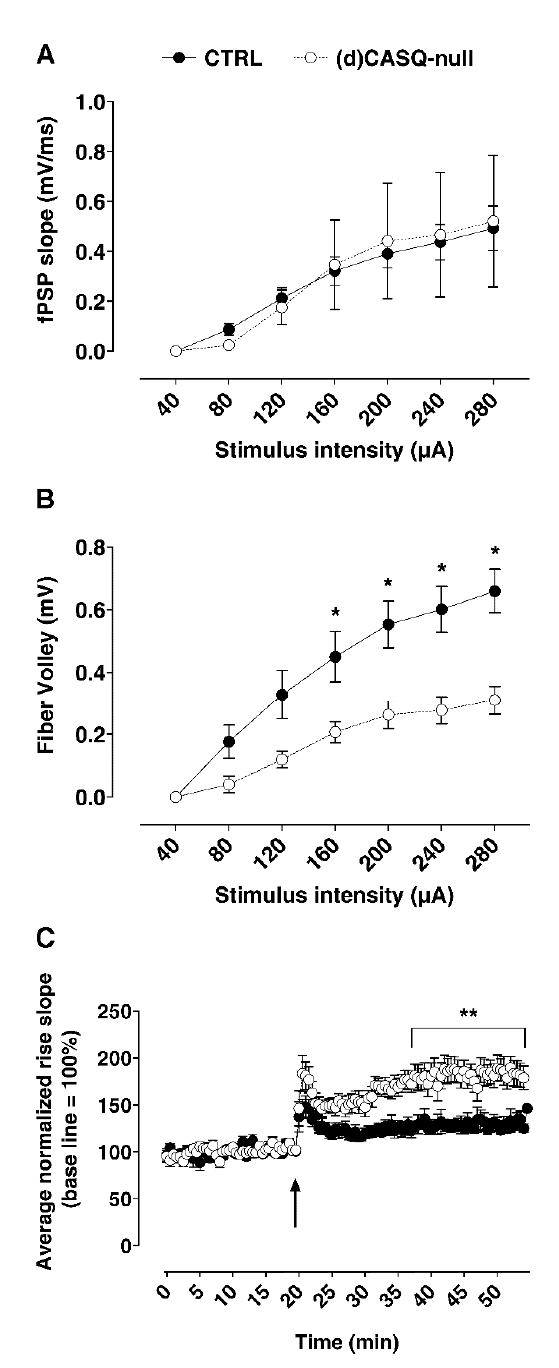
Figure 2. Extracellular field post-synaptic potentials (fEPSPs) recorded in the CA1 stratum radiatum. ( A ) Relationship between the fEPSP slope and the stimulus intensity. ( B ) Fiber volley amplitude vs. stimulus intensity. CTRL ( n = 8 slices from 6 animals) vs. (d)CASQ-null ( n = 6 slices from 5 animals). Two-Way ANOVA test: F(1, 84) = 49.42, p < 0.01; Sidak’s multiple comparisons test: * p < 0.05, ** p < 0.01. ( C ) fEPSP slope (10% and 80% of max) recorded before and after the Scha ff er Collateral high-frequency stimulation: the arrow indicates the stimulus application. Values were normalized to the mean value obtained over the last 20 min of the baseline period and expressed as a percentage of this baseline value ( n = 9 slices from 6 animals vs. n = 10 slices from 5 animals in CTRL and (d)CASQ-null, respectively). Two-way ANOVA test: F(1,17) = 13.06, p < 0.01; Sidak’s multiple comparisons test: ** p < 0.01.